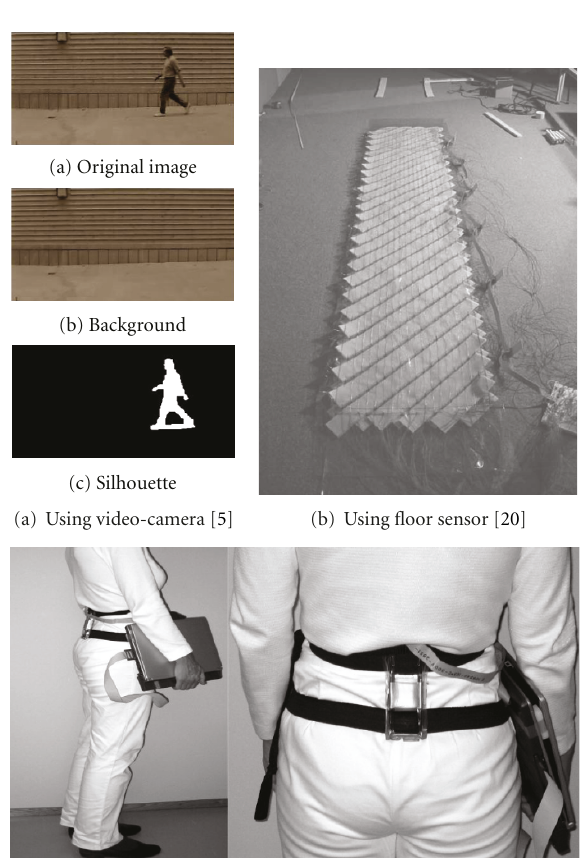
Figure 1: Examples of collecting gait.